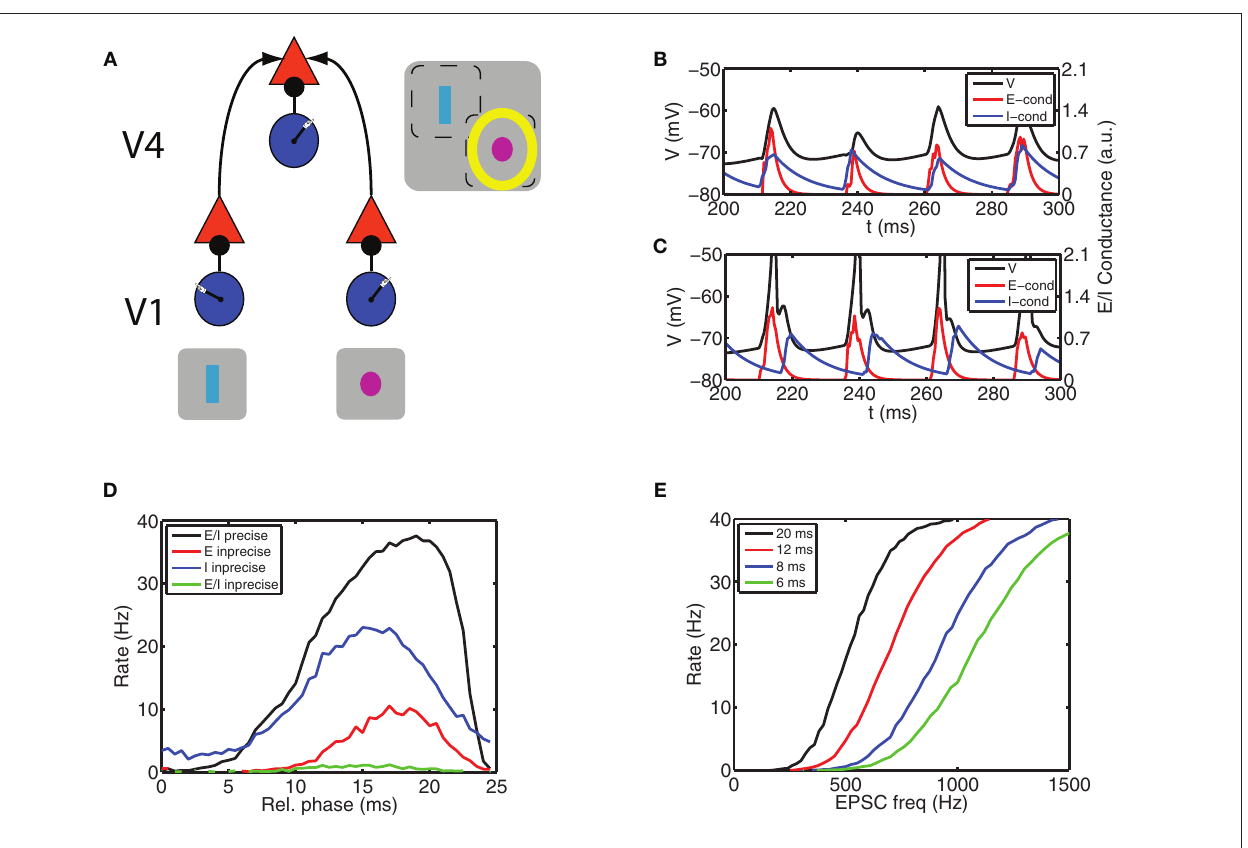
Figure 1 | Communication through coherence (CTC) requires synchronous inhibition and excitation. (A) A possible mechanism for CTC (Fries, 2005; Tiesinga and Sejnowski, 2009). We consider three local circuits each comprised of a network of excitatory (E) and inhibitory (I) cells, with at least an inhibitory projection from the I to E cells. Two are in primary visual cortex (V1) and send an excitatory projection to the third one located in V4. The receptive field of each circuit is indicated by the gray squares that contain the schematic stimuli to which the V1 circuits respond: a rectangle for the left circuit and a circle for the right circuit. The V4 circuit responds to both stimuli. The yellow halo indicates that locus of spatial attention is at the circle stimulus. We explore how CTC can make the response of the circle preferring circuit in V1 become more effective in driving the neurons in the V4 circuit. The E cells in V4 receive local synchronized inhibition and two streams of synchronized E volleys. The following panels show that only the E stream arriving before inhibition can be effective in driving the neurons in V4. (B) When volleys of synchronized E activity arrive shortly after or at the same time as the I volley, the postsynaptic neuron does not spike, whereas (C) when the inhibition is delayed with respect to excitation the neuron does spike. We show (blue) I and (red) E conductance waveform (in arbitrary units, with the latter